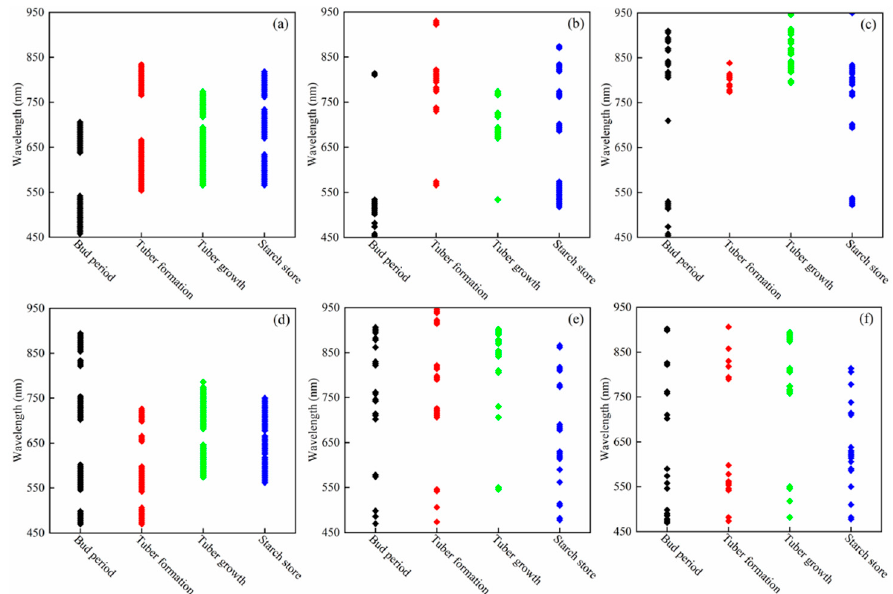
Figure 6. Distribution of wavelengths based on CRS and FDS using three wavelength-screening methods for potatoes for each growth period. ( a , d ) Characteristic wavelength distribution using MWPLS based on CRS and FDS, respectively. ( b , e ) Characteristic wavelength distribution using MC-UVE based on CRS and FDS, respectively. ( c , f ) Characteristic wavelength distribution using RF based on CRS and FDS,